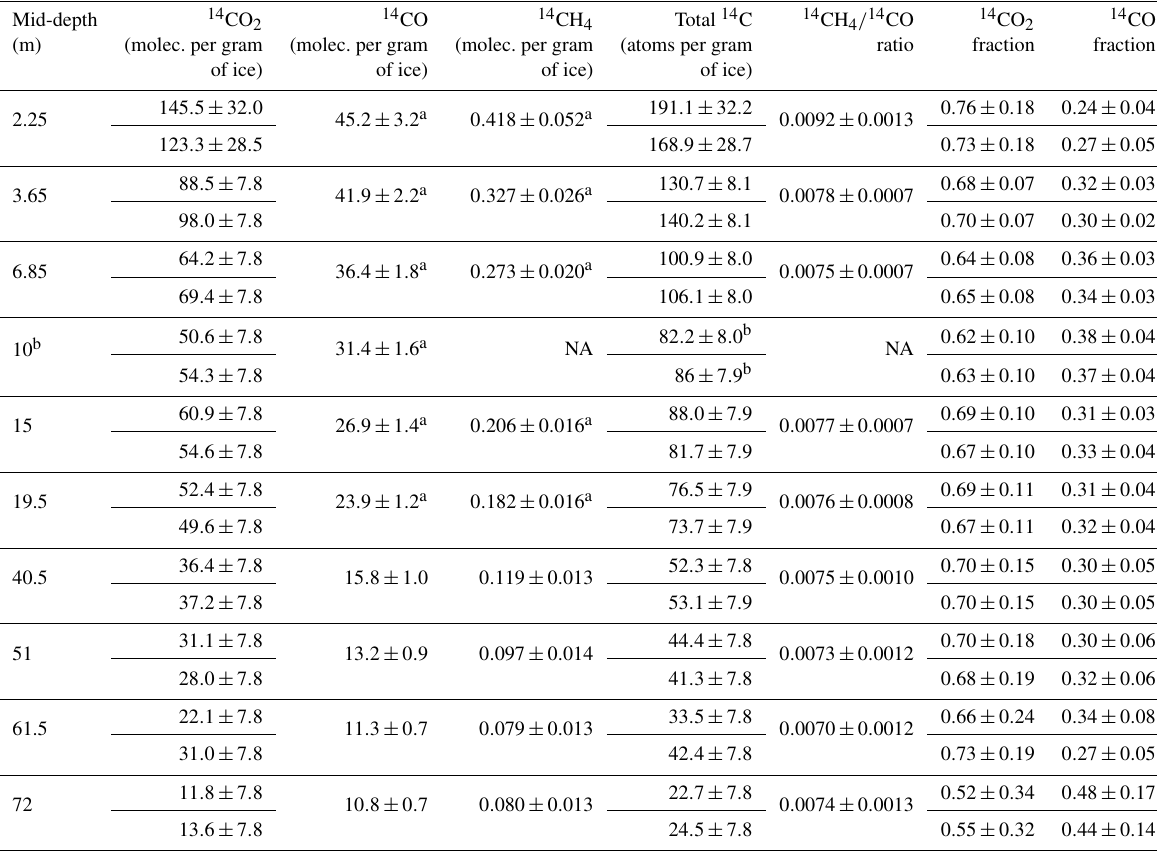
Table 1. Measured 14 CO 2 , 14 CO, and 14 CH 4 after all associated corrections and calculated total 14 C, 14 CH 4 / 14 CO ratios, 14 CO 2 , and 14 CO fractions. All errors presented indicate the 95% CI. NA – not